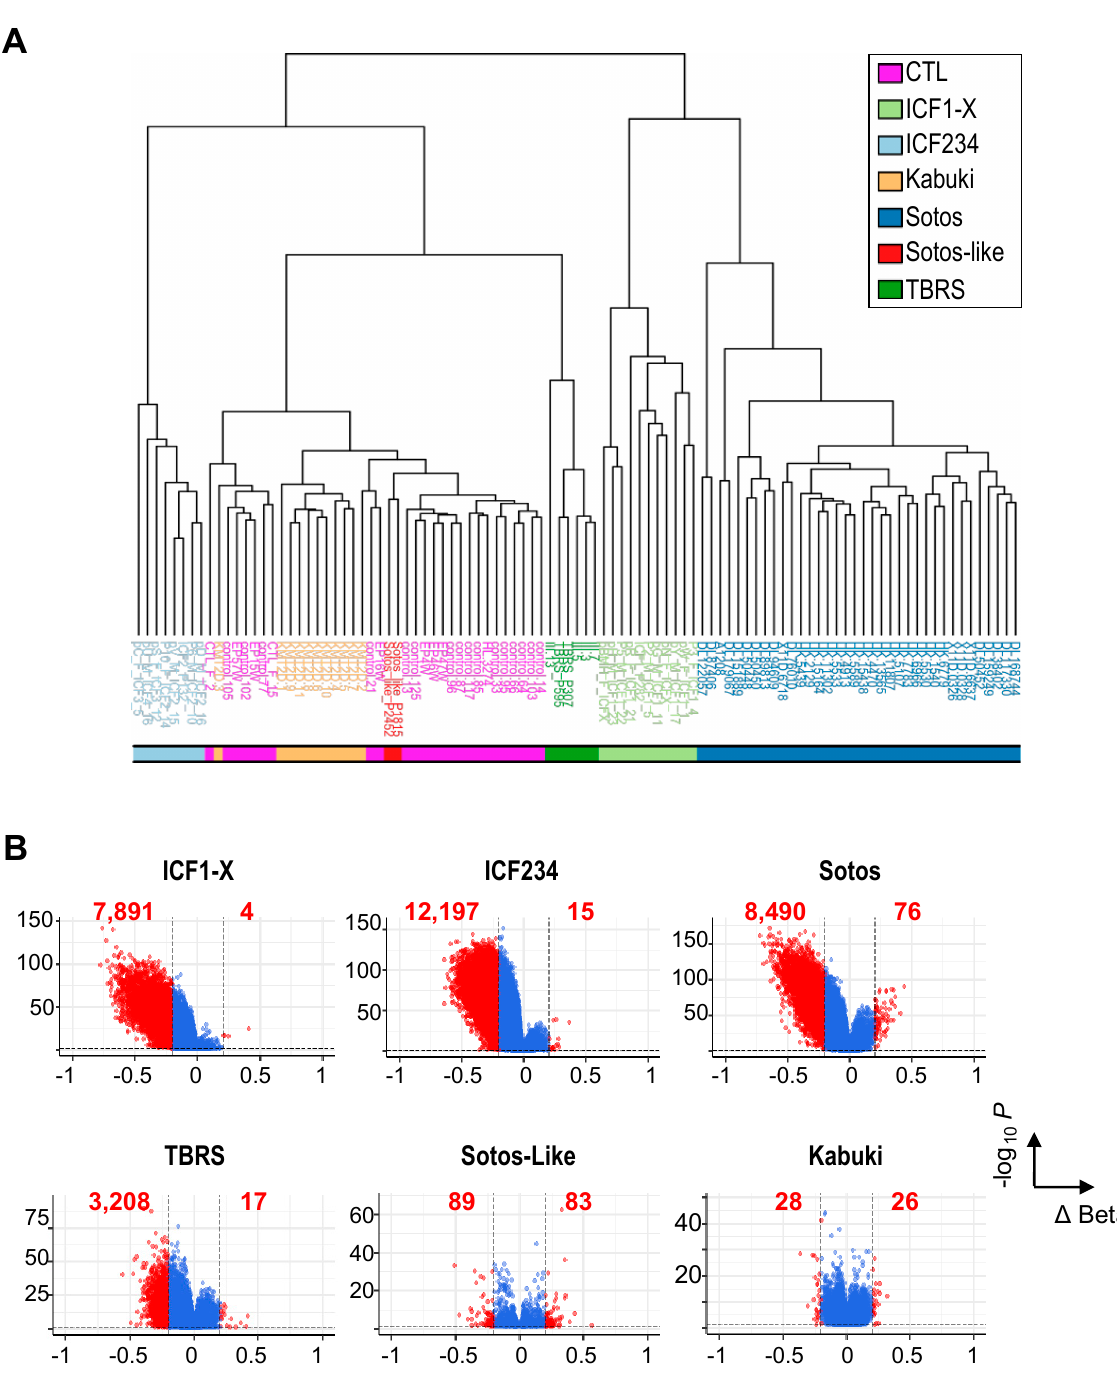
Figure 1. Genome-wide DNA methylation profiling discriminates inherited disorders of the epigenetic machinery. ( A ) Unsupervised clustering of non-affected individuals (CTL) and patients based on the total Differentially Methylated Probes (DMP) identified (28,102 probes). The colored bar at the bottom indicates groups of patients according to their diagnosis. ( B ) Volcano plots of DMPs between patients and non-affected individuals. The mean differences in β -values ( ∆ Beta) are plotted on the X axis and their statistical significance [ − log10 ( p -value)] on the Y axis. DMPs with a ∆ Beta ≥ 0.2 and p -values ≤ 0.05, further considered for analysis, are plotted as red dots. The number of hypo- ( ∆ Beta ≤ − 0.2) and hyper- ( ∆ Beta ≥ 0.2) methylated probes are indicated in red for each group of patients.